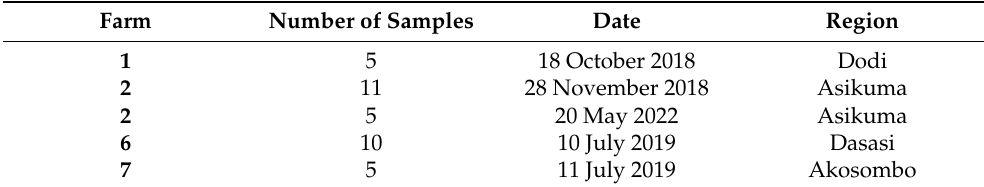
Table 1. Dates and regions for collection of the 36 samples from four different farms in Lake Volta, Ghana. Data for Farms 3–5 have been described previously [11].